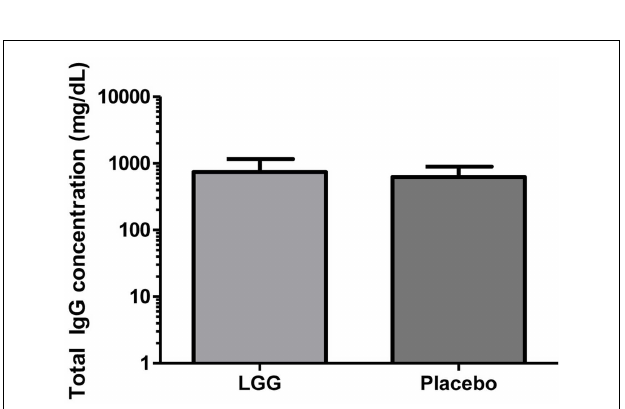
FIGURE 4 | Level of total IgG in the serum of infants (GMC ± 95% CI) in the LGG ( N = 31) and Placebo ( N = 30) groups .